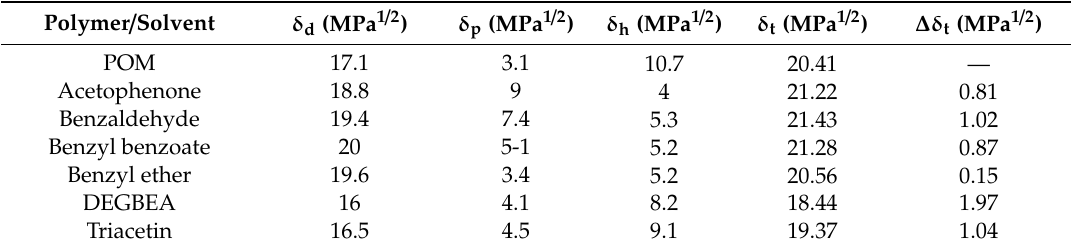
Table 1. Hansen solubility parameters of Polyoxymethylene (POM) and tested solvents [53]. DEGBEA, diethylene glycol n-butyl ether acetate.